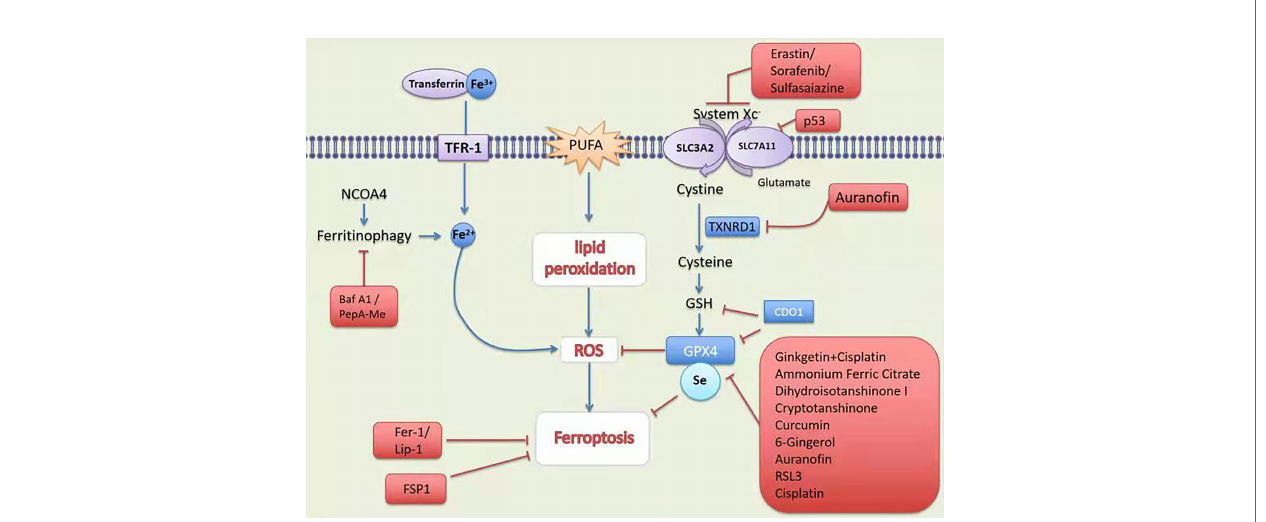
FIGURE 1 | Mechanism and treatment of ferroptosis. TFR-1, transferrin receptor 1; PUFA, polyunsaturated fatty acids; SCARA5, scavenger receptor class A member 5; SLC1A5, solute carrier family member 1 member A5; System Xc-,contribution of the cystine-glutamate antiporter; NCOA4; Nuclear receptor coactivator 4; GSH, glutathione; Fer-1, ferrostatin-1;Lip-1, lipoxstatin-1; FSP1, ferroptosis suppressor protein 1; GPX4, glutathione peroxidase 4; p53, tumor suppressor protein 53; TXNRD1, thioredoxin reductase 1; CDO, cysteine dioxygenase 1; RSL3, RAS-selective lethal 3.